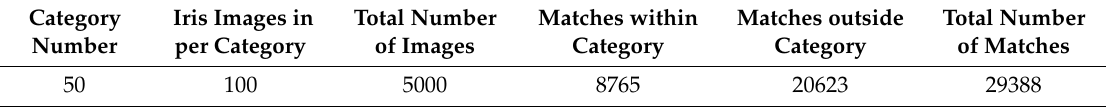
Table 3. Number of comparisons in feature recognition layer experiment.